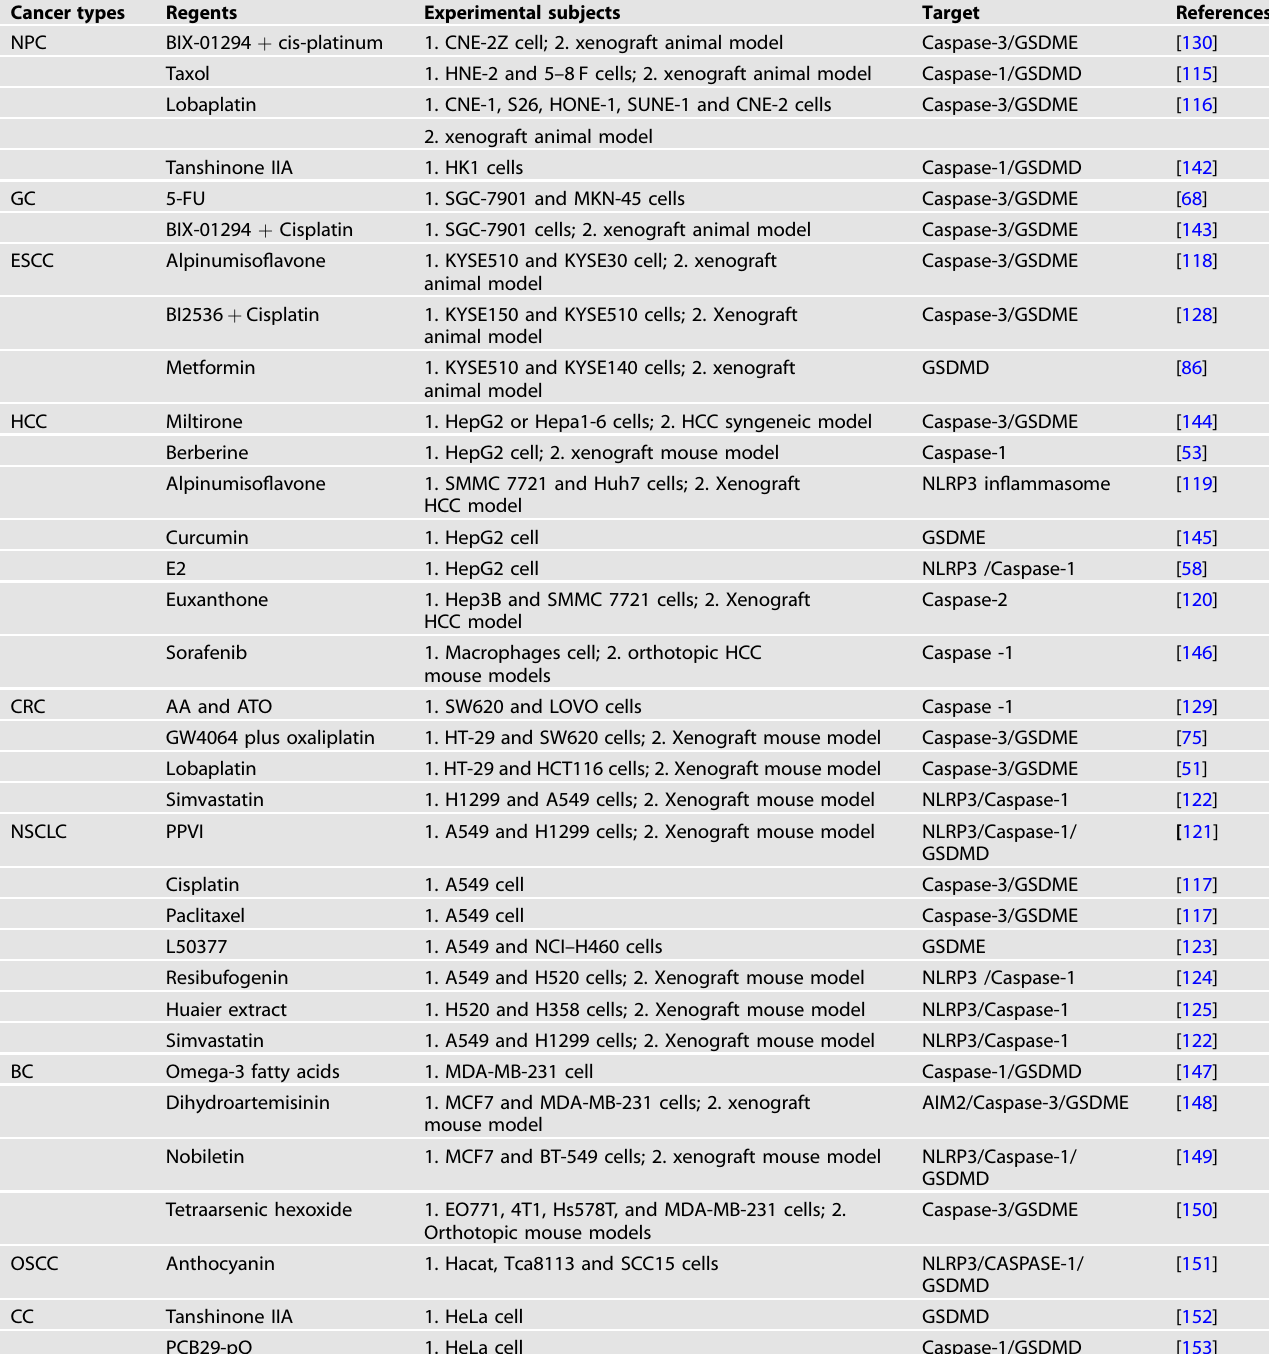
Table 3. Summary of regents induce pyroptosis in